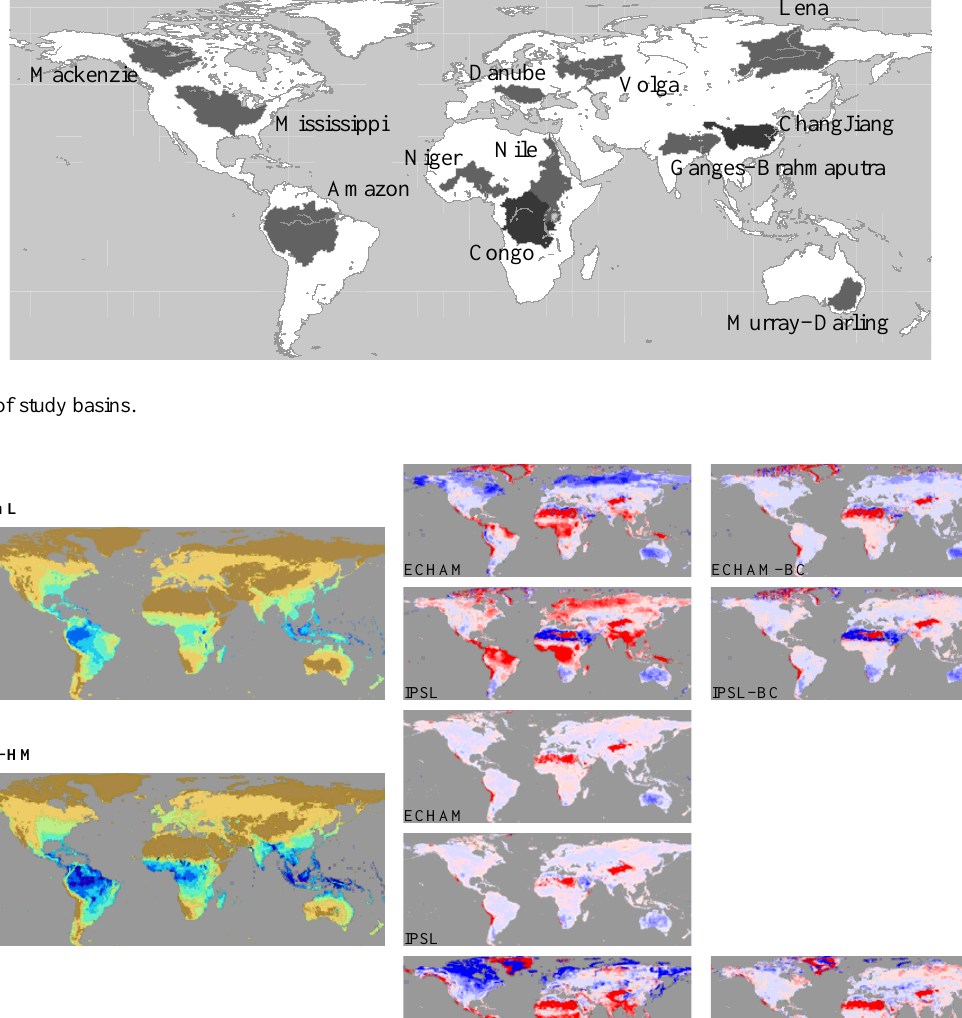
Fig. 2. Location of study basins.